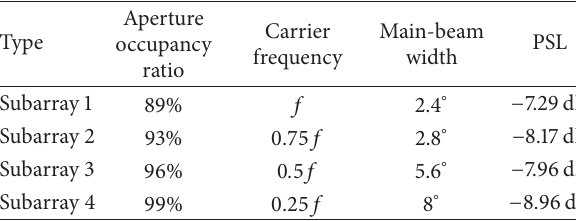
Table 1: Performance parameters for the interleaved subarrays. Type